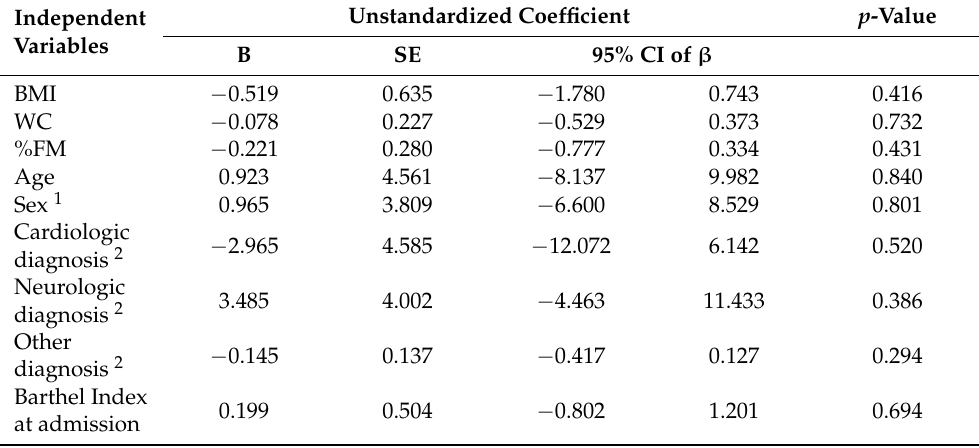
Table 4. Multiple regression analyses considering ∆ Barthel Index (t3 – t2) as dependent variable ( n =